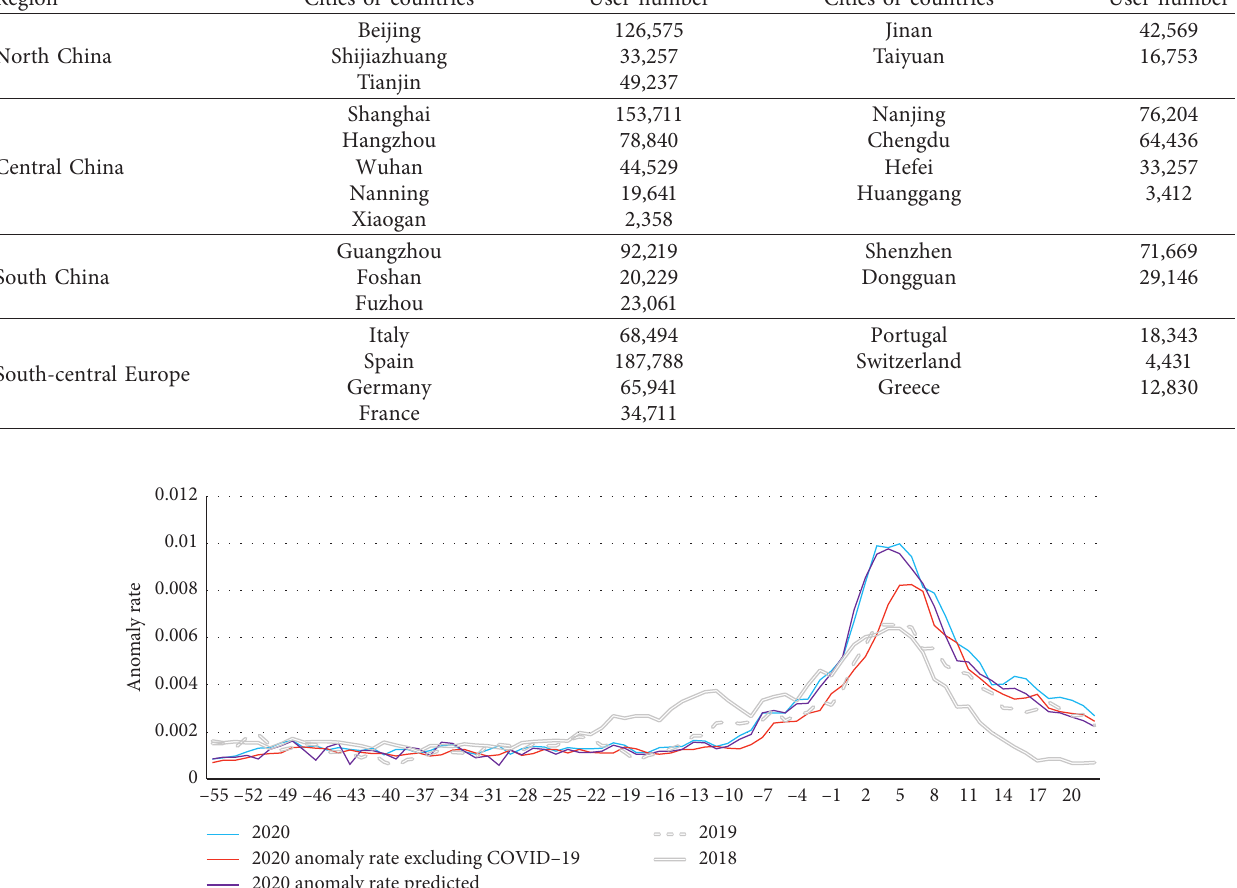
Figure 4: Physiological anomaly rate curves in Wuhan aligned by the time of Chinese Spring Festival. The two grey curves and the blue curve represent the physiological anomaly rate calculated by the anomaly detection algorithm from 2018 to 2020, respectively. The purple curve and the red curve represent the predicted physiological anomaly rate with and without the supervision of the official data,